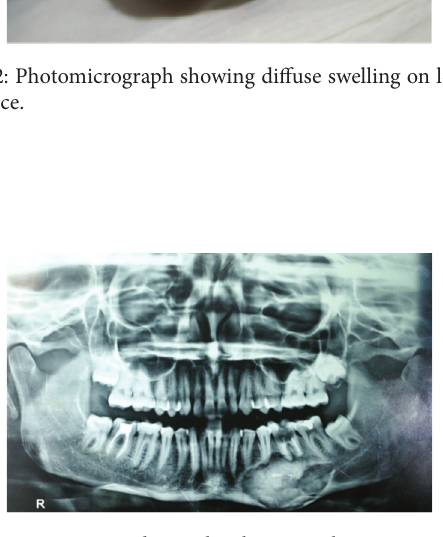
Figure 3: Panoramic radiography showing a homogenous radioo- pacity with thin radiolucent border from lower left canine to the lower left second molar.